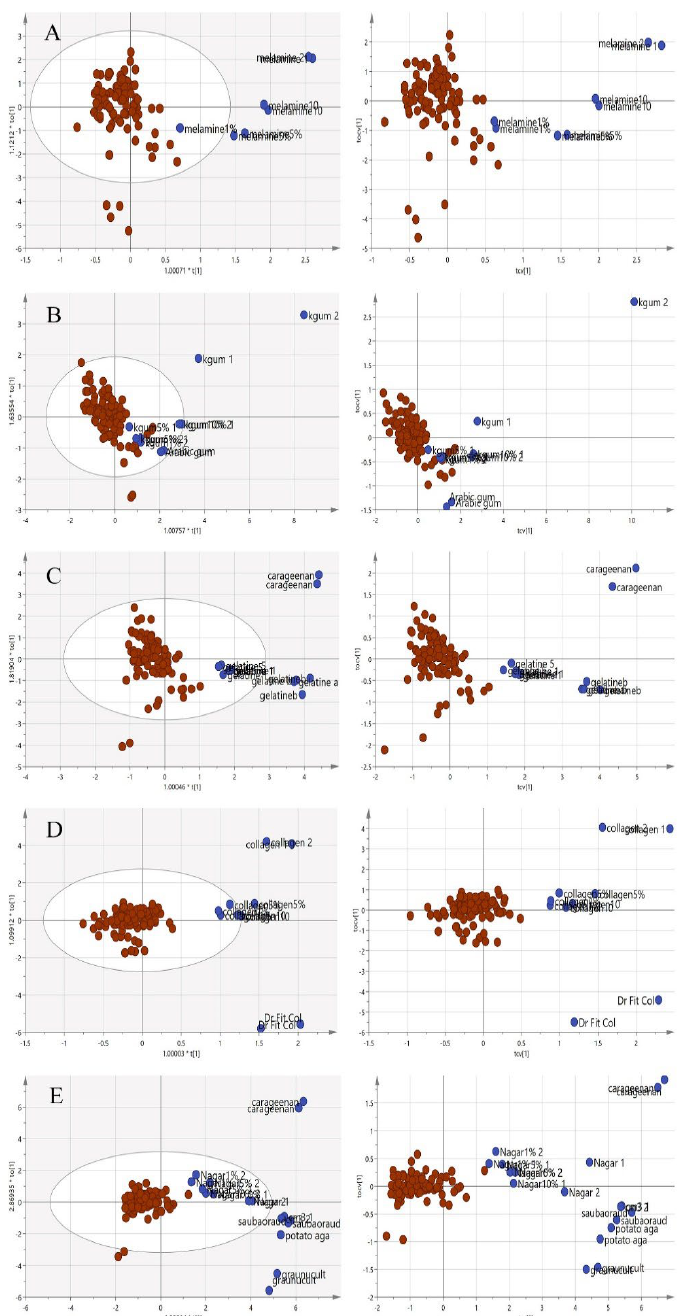
Figure 9. Each tier of (( A ) to ( E )) consists of a two-class OPLS-DA score model plotted side by side with the CV score model using VIS/SW-NIR spectra (( A ) melamine, ( B ) karaya gum, ( C ) gelatine, ( D ) collagen and ( E ) nutrient agar). The overlap of some points from both classes in the CV score model indicated that the assignment of the class was uncertain (authentic: , non-authentic: ).